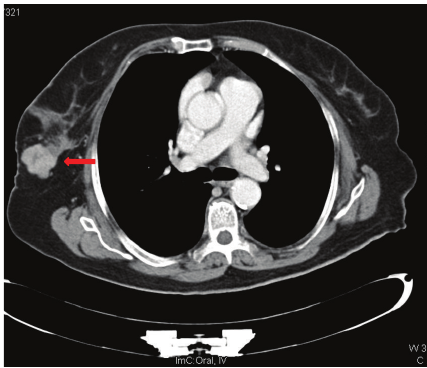
Figure 1: CT of abdomen. The red arrow illustrates a well circum- scribed, multilobulated 3.3 cm lesion in the inferior outer quadrant of the right breast.